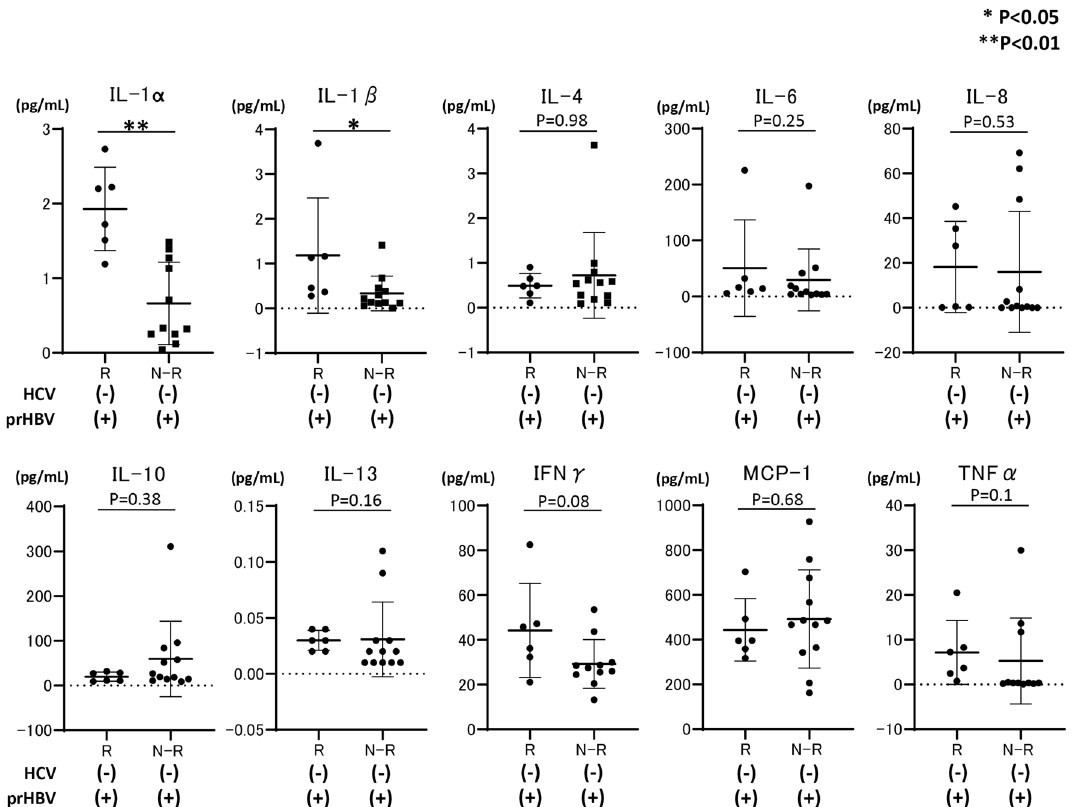
Figure 5. Comparison of baseline cytokine levels among HCV-non-infected patients with previous HBV infection with or without HBV reactivation during anti-cancer/immunosuppressive therapy or bone marrow transplantation. Each data are shown as median ± SD. *P < 0.05, **P < 0.01. HCV hepatitis C virus, HBV hepatitis B virus, IL interleukin, MCP monocyte chemotactic protein, IFN interferon, TNF tumor necrosis factor, SD standard deviation, R HBV reactivation, N-R non-HBV reactivation, prHBV previously resolved HBV